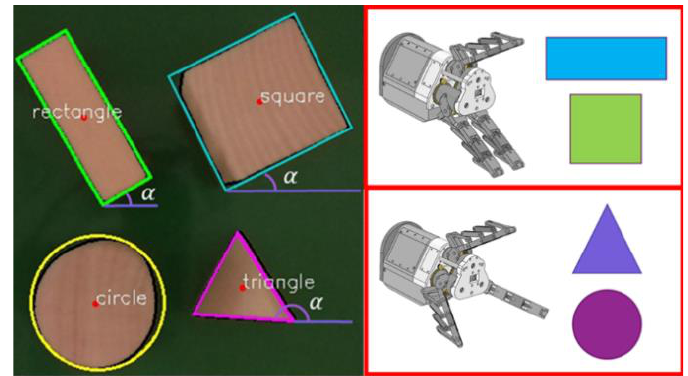
Figure 22. Shape profile and centroid location identified by the Douglas – Peucker algorithm ( left ). Illustration of two-finger ( right-top ) and three-finger ( right-bottom ) modes of the gripper for the corresponding object shapes.